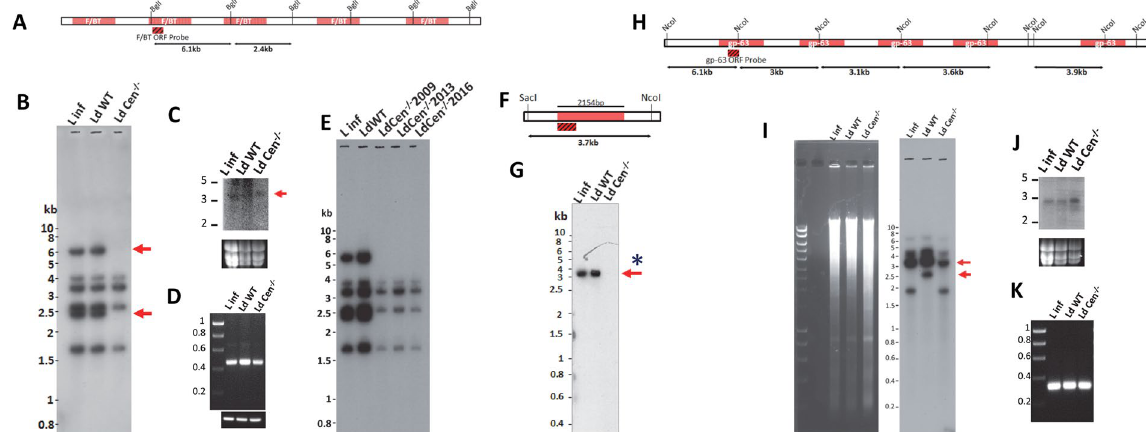
Figure 4. Experimental validation of the predicted deletions in the LdCen − / − genome. ( A ) The predicted sizes of the BglI digested fragments upon Southern hybridization and the probe used are indicated. ( B ) Southern hybridization of BglI digested L . infantum , LdWT and LdCen − / − gDNA is shown. ( C ) Northern blot with 20 µ g of total RNA from L . infantum , LdWT and LdCen − / − parasites hybridized with the folate/biopterin transporter probe is shown. The ribosomal RNA bands as loading controls are shown at the bottom. ( D ) RT-PCR with 1 µ l product of the first strand cDNA synthesis reaction that amplified a fragment of the folate/biopterin transporter ORF. Loading control showing a comparable amplification of an unrelated gene fragment (LdUfsp1) is at the bottom. ( E ) Southern blot hybridization of folate/biopterin transporter genes with three additional stocks of LdCen − / − parasites collected over a period of 7 years (2009, 2013 and 2016). ( F ) The predicted size of SacI-NcoI digestion fragment and the probe corresponding to Δ 2154 bp deletion in LdCen − / − genome are shown. ( G ) Southern hybridization with a 32 p labeled probe derived from the 2154 bp deletion upon SacI-NcoI digested L . infantum , LdWT and LdCen − / − gDNA is shown. Absence of the predicted 3.7 kb fragment in LdCen − / − , is indicated with a red arrow. ( H ) The predicted restriction map upon NcoI digestion of genomic DNA for tandem gp63 copies is shown. The location of the probe used in hybridization experiments is indicated with red. The predicted sizes of the fragments upon Southern hybridization are indicated as black arrows. ( I ) Agarose gel showing the NcoI digested L . infantum , LdWT and LdCen − / − gDNA. Southern hybridization of NcoI digested L . infantum , LdWT and LdCen − / − gDNA is shown. Reduced intensity of a ~3 kb fragment in LdCen − / − lane compared to L . infantum and LdWT lanes is indicated with a red arrow. ( J ) Northern blot with 20 µ g of total RNA from L . infantum , LdWT and LdCen − / − parasites upon hybridization with the gp63 probe is shown. The ribosomal RNA bands as loading controls are shown at the bottom. ( K ) RT-PCR with 1 µ l product of the first strand cDNA synthesis reaction that amplified a fragment of the gp63